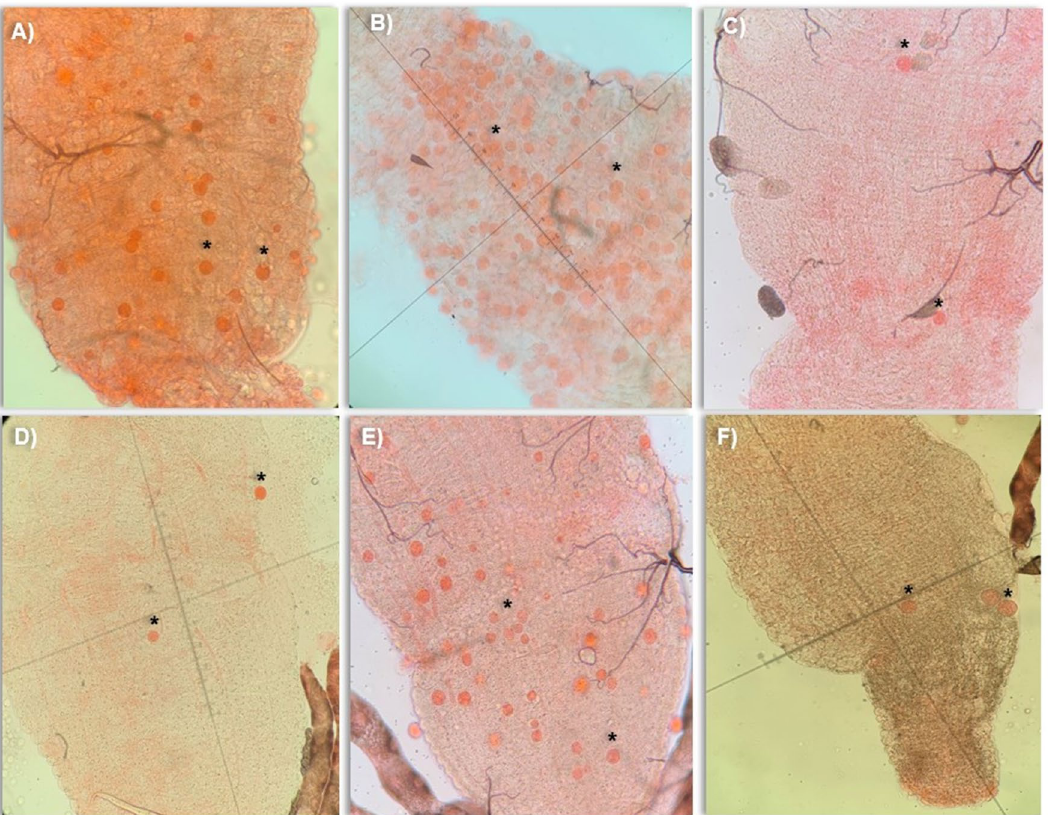
s.l.; ( E ) An. evansae ; ( F ) An. benarrochi s.l. * =